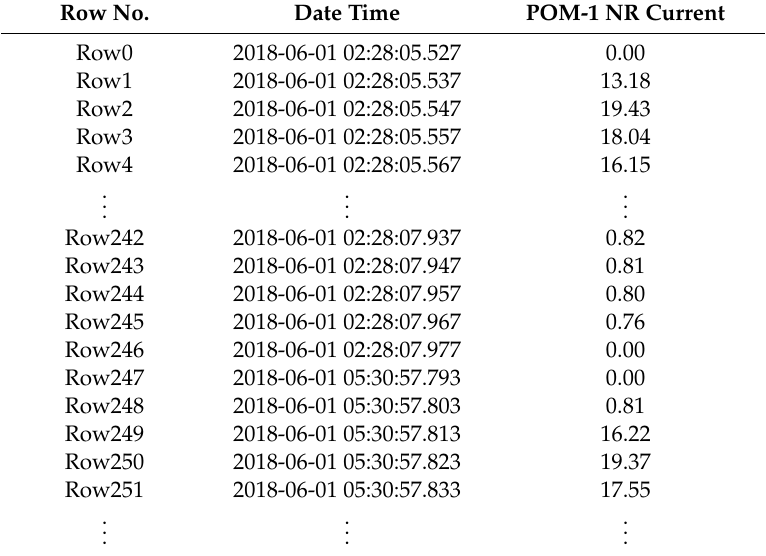
Table 2. Current (A) draw signal data for point-operating machine POM-1 moving in the NR direction. Row